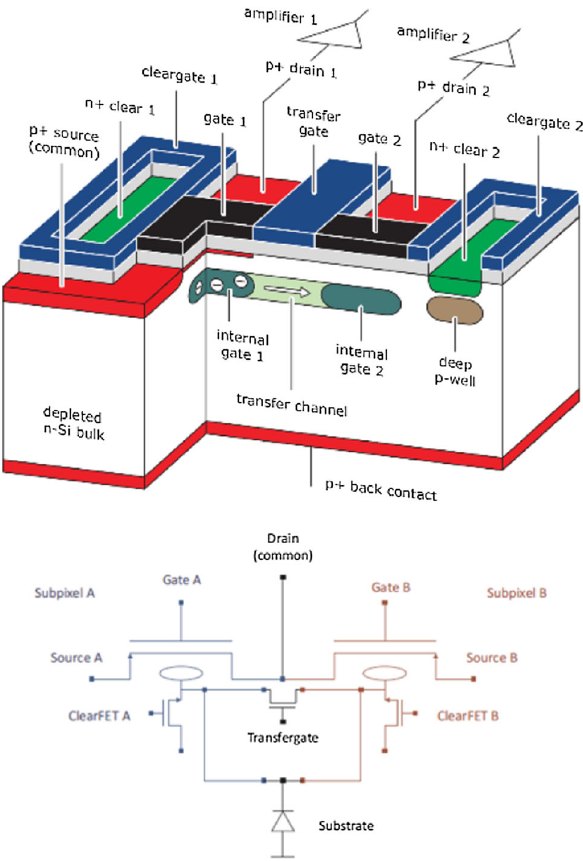
Fig. 4 Structure (top) and circuit representation (bottom) of RNDR DEPFET superpixel consisting of two DEPFET subpixels with linear